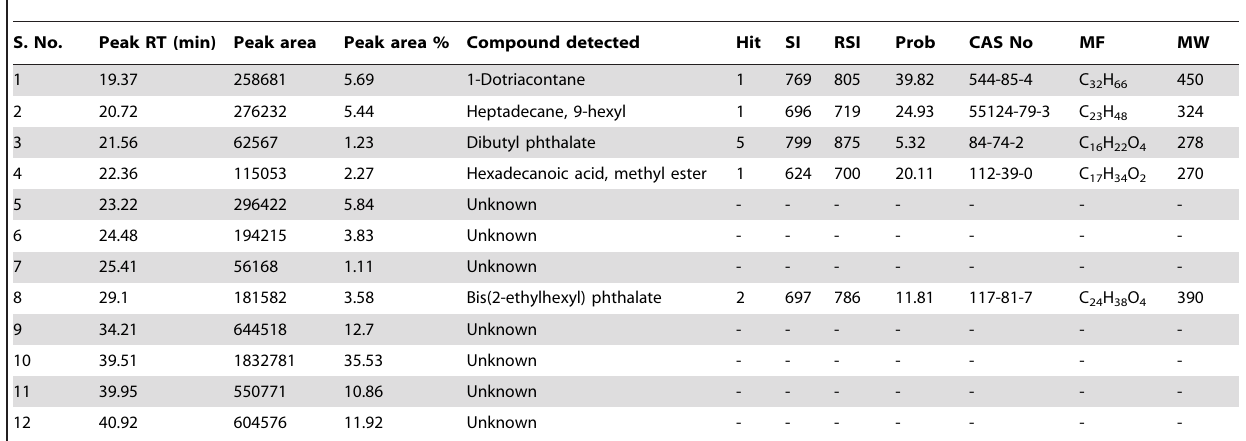
Table 6. Phyto-chemotypes identified in the 60% ethanol root extract of R. imbricata by GC/MS.